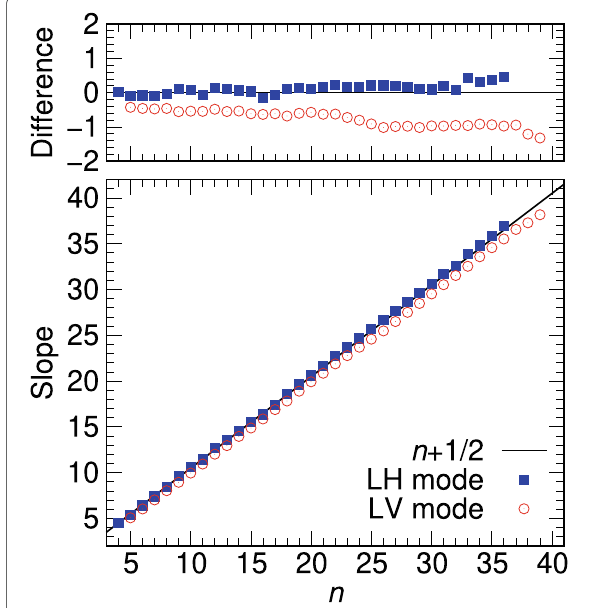
Fig. 13 Slope parameters in the LH and LV modes. (bottom) Slope of linear fitting of path length vs λ plot and (top) difference of slope from n + 1/2. Squares and circles are the results of the linear fitting, and the black solid line is n +